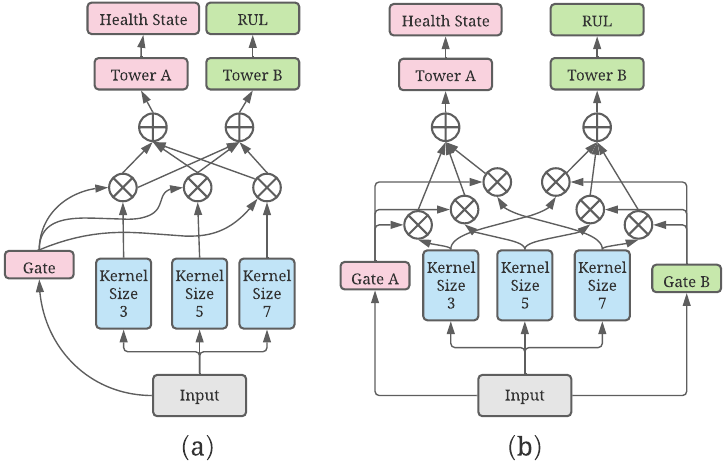
Figure 4. Construction of ( a ) proposed GMM-Net; ( b ) a multiscale net with two